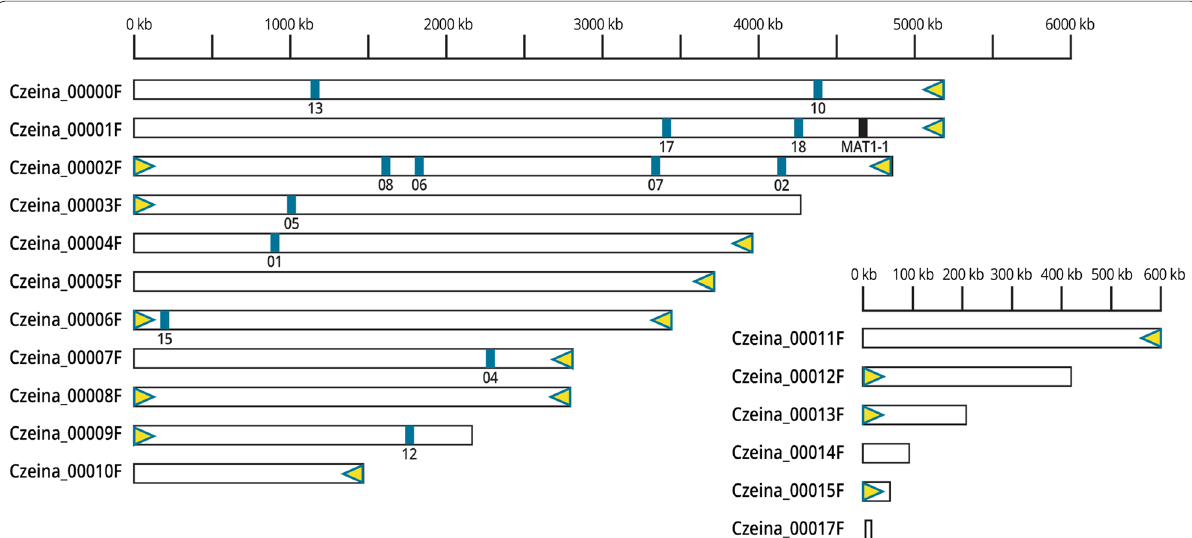
Fig. 3 Cercospora zeina (CMW25467) PacBio genome assembly with positions of microsatellite markers and CCC TAA telomere repeats. The 17 nuclear contigs with protein coding genes are shown (Czeina_00000F‑Czeina00017F). The five additional contigs 16F, 18F, 19F, 20F, 21F are not shown (sizes < 30 kbp). The telomere repeats are shown by yellow triangles. Contigs 02F, 06F, 08F had telomere repeats at both ends. The MAT1-1 gene is located on contig 01F (black bar). Blue bars represent the locations of 13 microsatellite markers (with the CzSSR number below each bar) from (Muller et al. 2016). Contig 20F contained CzSSR11 (not shown). Different scale bars (kbp) are shown above contigs Czeina_00000F to Czeina_00010F; and contigs Czeina_00011F to